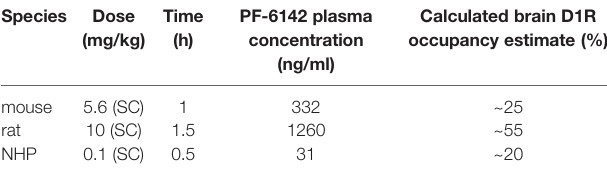
TABLE 2 | Representative Exposure